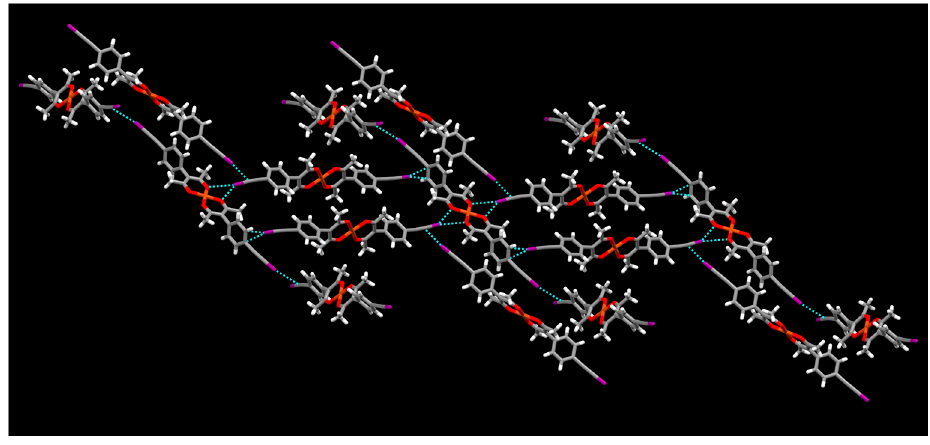
Figure 17. The halogen-bond driven assembly of complex ions in the crystal structure of [Cu( L3) 2 ] (color codes: red—oxygen; purple—iodine; orange—copper).